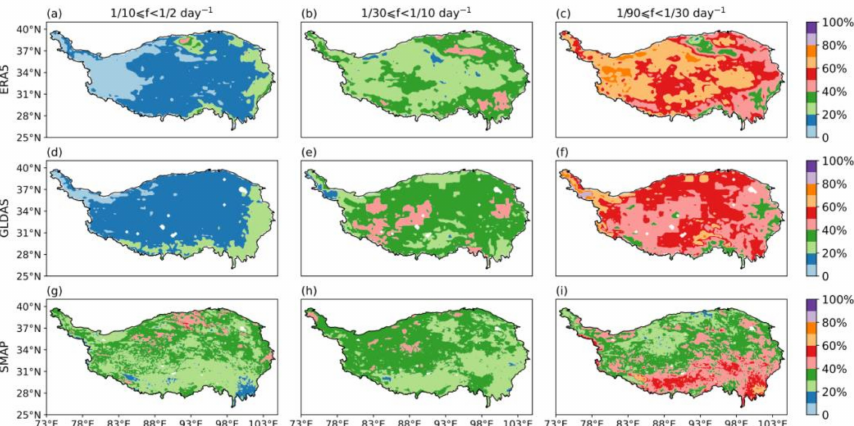
Figure 11. Variance percentages of the (left column) high-, (central column) intermediate-, and (right column) low-frequency bands from ( a – c ) the fifth-generation European Centre for Medium-Range Weather Forecasts atmospheric reanalysis (ERA5), ( d – f ) Global Land Data Assimilation System